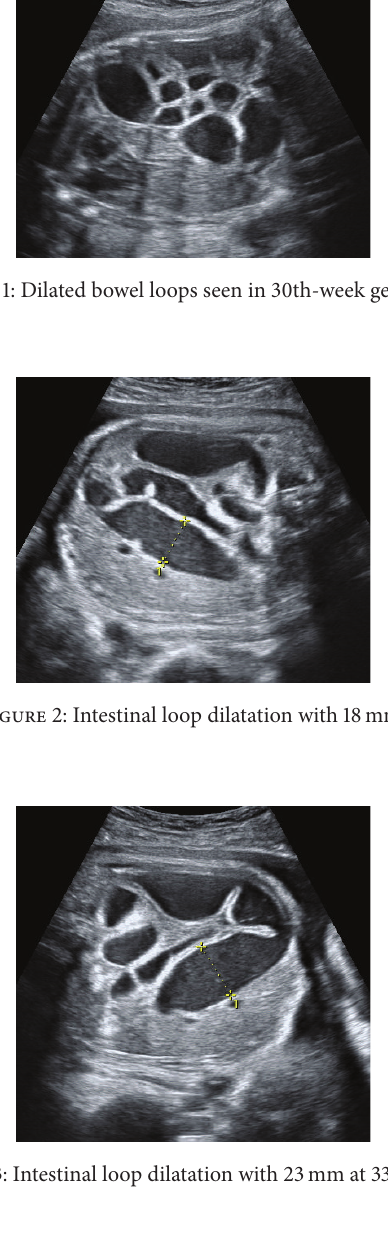
bowel resection with end-to-end jejunoileal anastomosis was performed. 80 cm of normal ileum as well as the ileocecal valve was left in place (Figure 6).